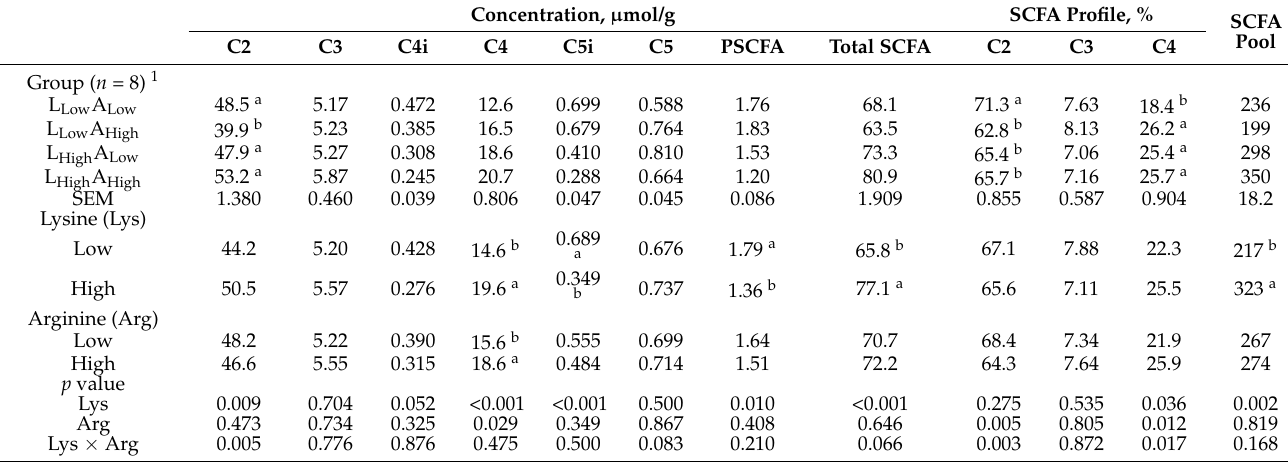
Table 4. Concentrations of short-chain fatty acids (SCFA) in the cecal digesta of experimental turkeys. Concentration, µ mol/g SCFA Profile, % SCFA PoolC2 C3